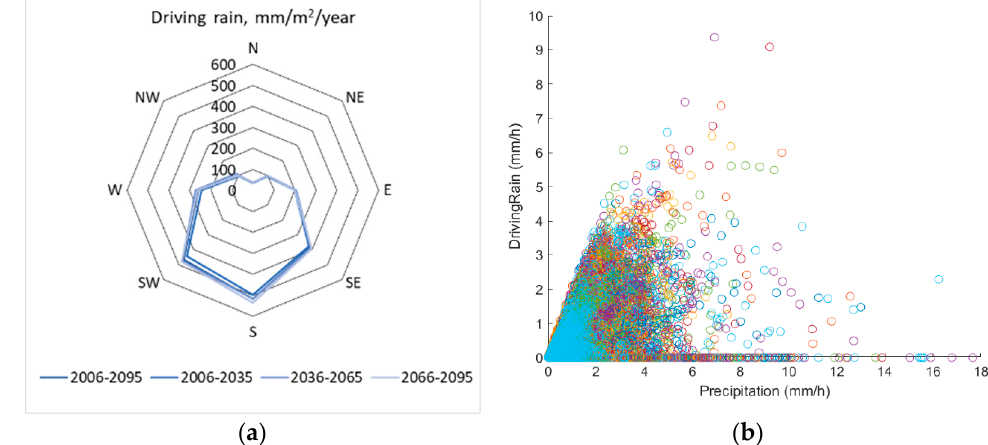
speed and wind direction using [29] for an exposed facade in an exposed 10 storey building.